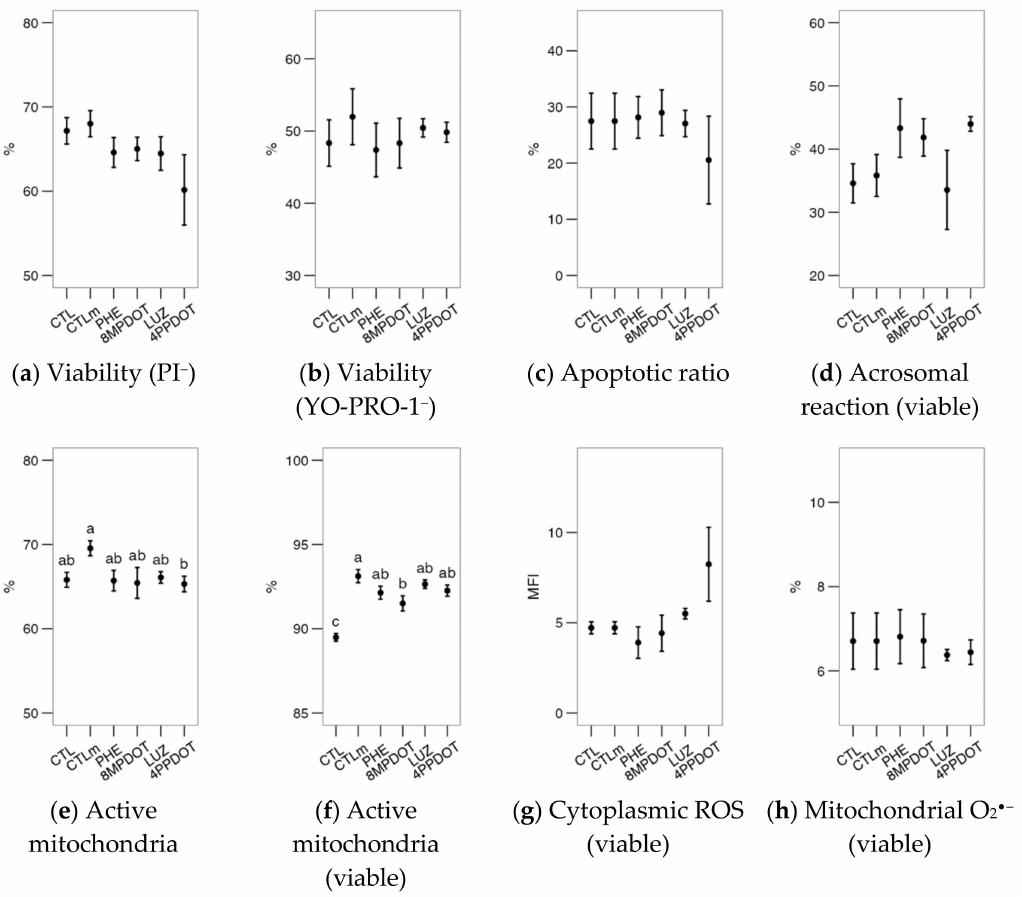
Figure 6. Effects on red deer epididymal sperm physiological parameters of melatonin receptor agonists (PHE: Phenylmelatonin; 8MPDOT: 8-Methoxy-2-propionamidotetralin) or antagonists with 10 nM melatonin (LUZ: Luzindole; 4PPDOT: cis-4-Phenyl-2-propionamidotetralin); CTL: Control; CTLm: Control with 10 nM melatonin. Plots show mean ± SEM for each treatment of five males. ( a ) Viable spermatozoa as maintaining membrane continuity (PI − ); ( b ) Viable, non-apoptotic sperma- tozoa (as YO-PRO-1 − ); ( c ) Apoptotic spermatozoa (YO-PRO-1 + ) as ratio of PI − ; ( d ) Acrosome-reacted spermatozoa (PNA + ); ( e ) Spermatozoa with active mitochondria (MitoTracker + ); ( f ) Spermatozoa with active mitochondria as a proportion of the viable population; ( g ) Cytoplasmic ROS production (H 2 DCFDA + ) of viable spermatozoa; ( h ) Spermatozoa with high mitochondrial superoxide produc- tion (MitoSOX + ) as a ratio of viable spermatozoa. Treatments not sharing the same letters differ significantly ( p <